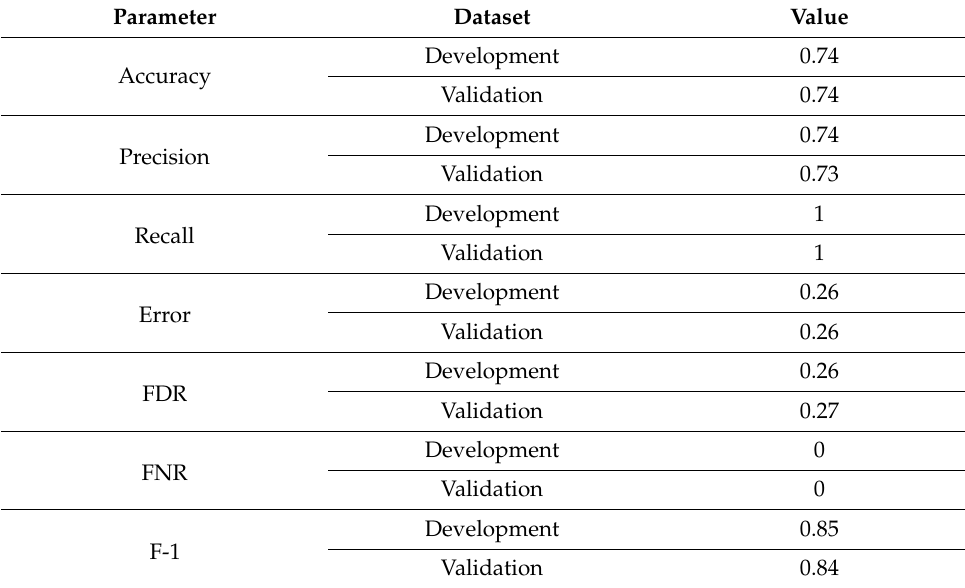
Table 8. Accuracy measures for the CART